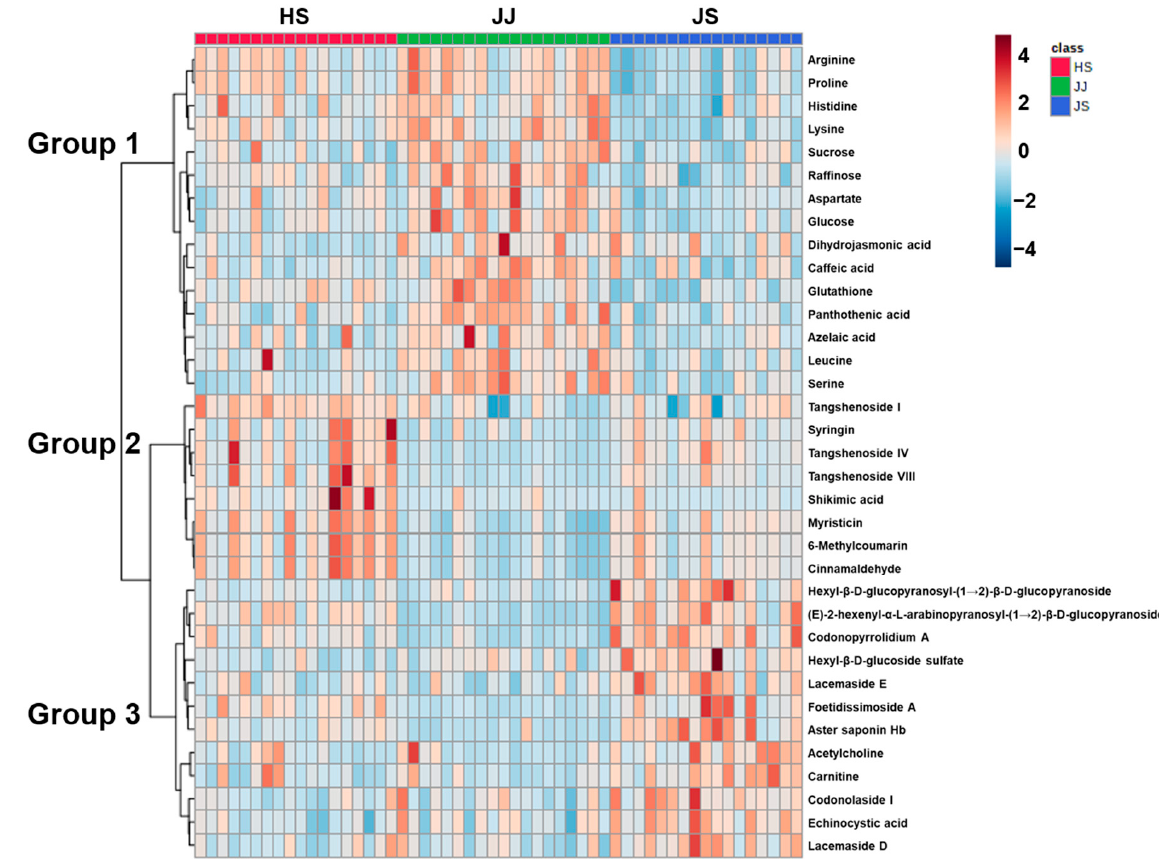
Figure 2. A heat map of metabolites with significant p -values ( p < 0.001) by Kruskal–Wallis analysis.